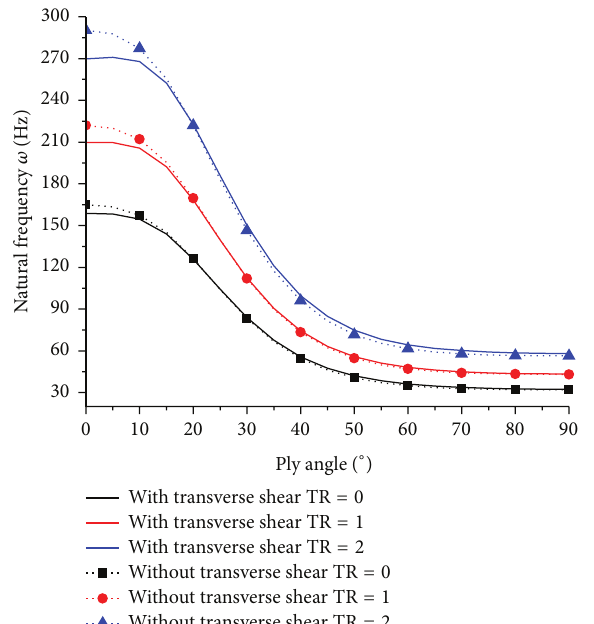
Figure 3: The influence of transverse shear deformation ( Ω = 0 rad/s).